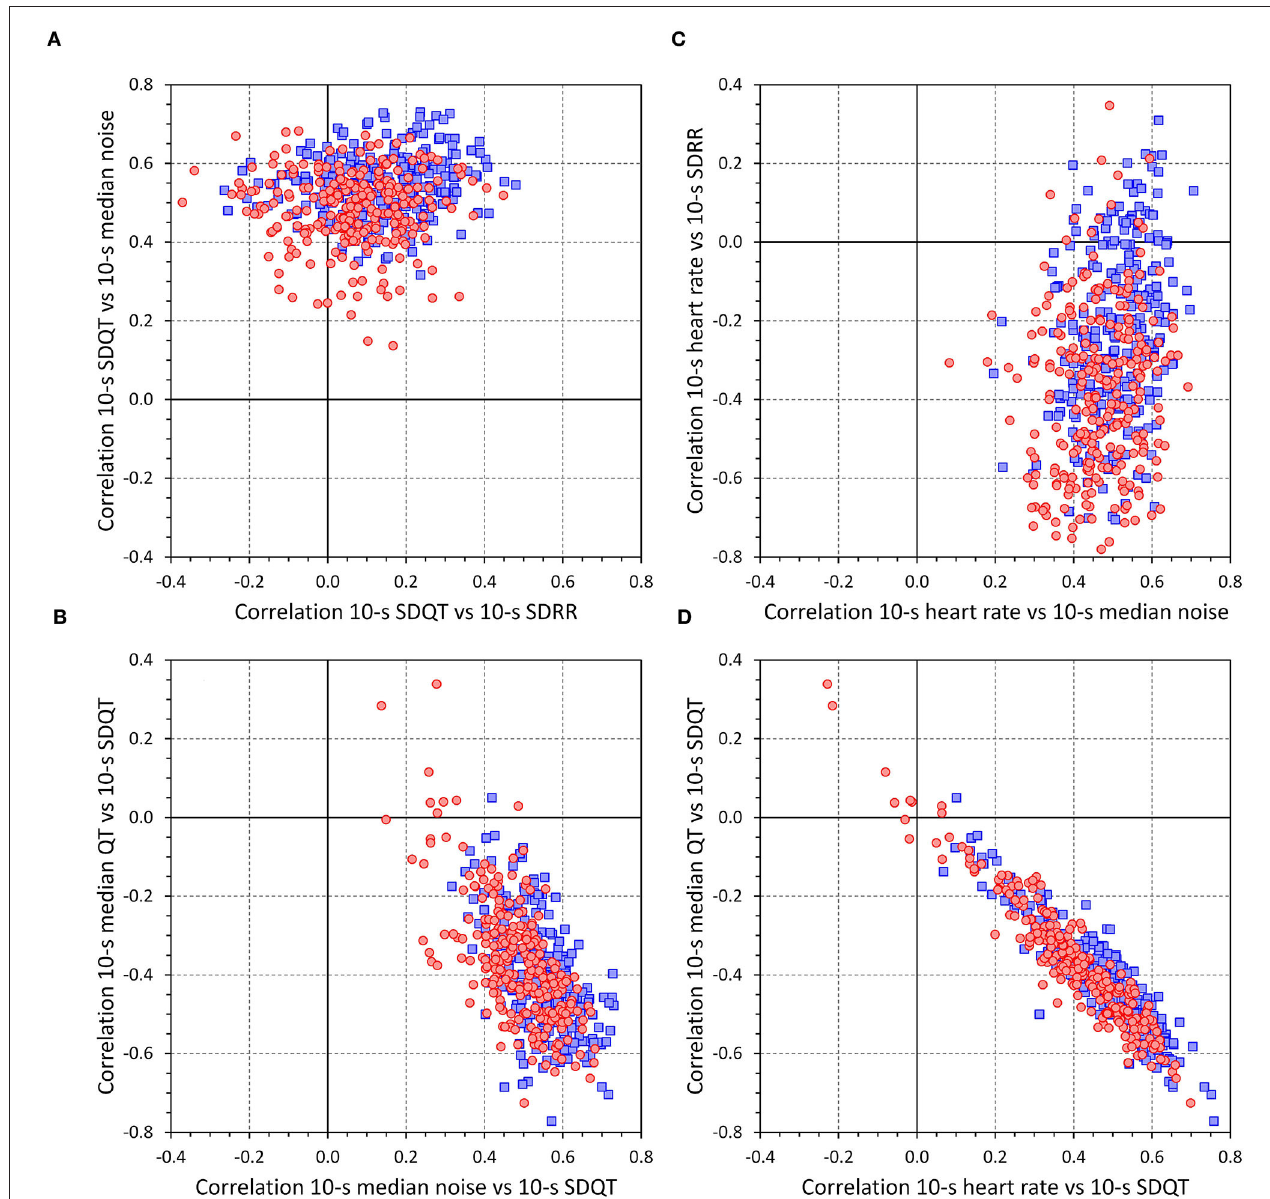
FIGURE 8 | The panels of the figure show scatter diagrams between intra-subject correlations between different measurements in accepted 10-s ECG segments [see the labels of the axes of (A–D) for the specification of the correlations]. In each panel, red circles and blue squares correspond to females and males, respectively.